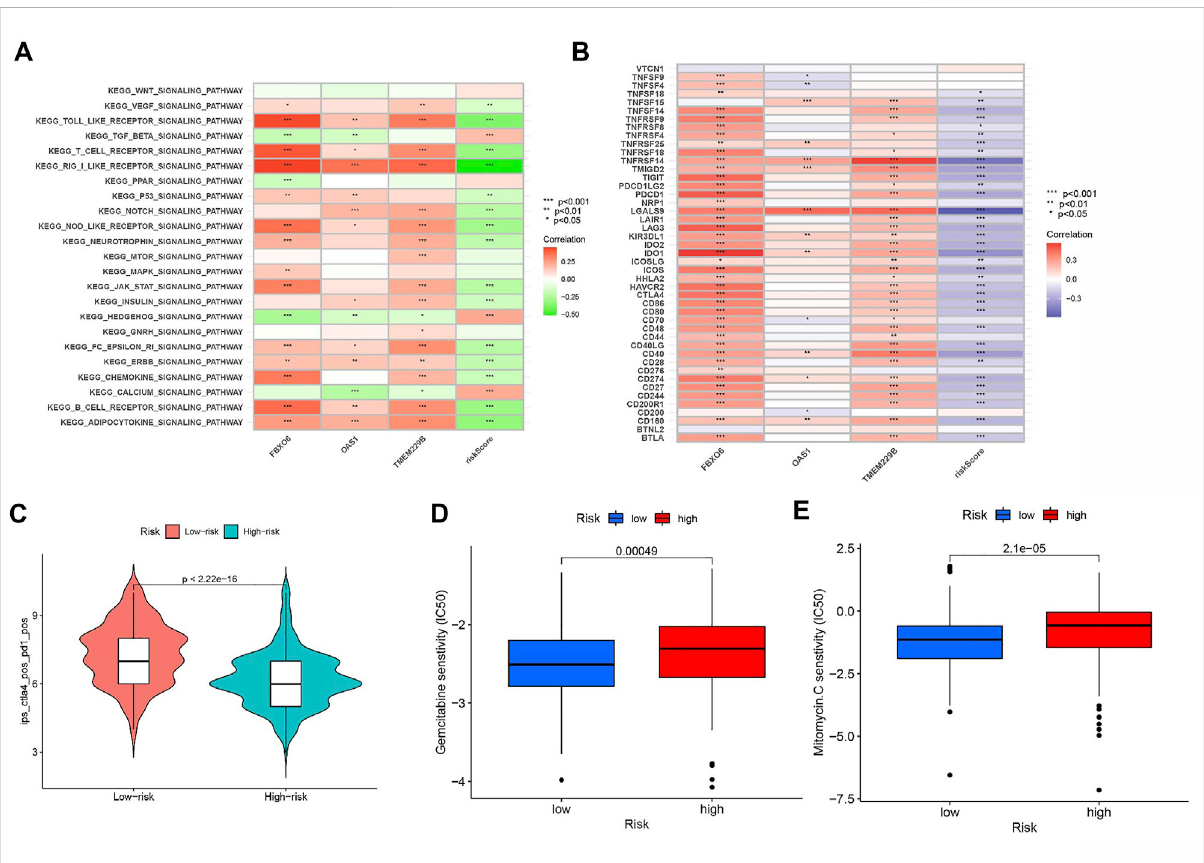
FIGURE 9 (A) Heatmap showing the correlation of representative pathway terms of KEGG with risk score. (B) Correlation of expression level of immune checkpointblockadegeneswithriskscore. (C) IPS scoredistributionplot.Estimationofriskscore ofchemotherapeuticeffect. (D) Sensitivity analysis of Gemcitabine in patients with high and low risk score. (E) Sensitivity analysis of Mitomycin C in patients with high and low risk